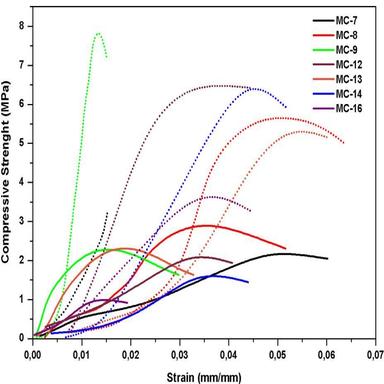
Stress-Strain diagram of the internal (dashed line) and the external (solid line) part of the RE samples.